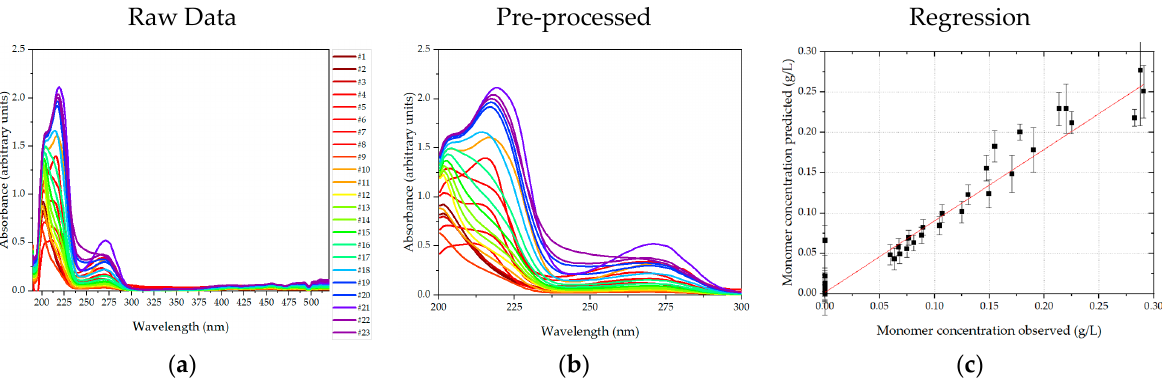
Figure 9. Data of DAD spectra ( a ), shortened spectra ( b ) and PLS results ( c ). Spectra are color-coded from high concentration (blue) to low concentration (red).